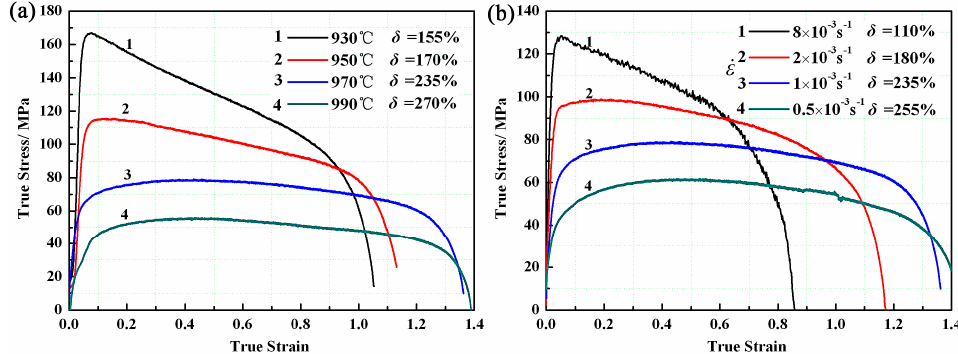
Figure 1. Stress–strain curves for the initial sheet: ( a ) various temperatures and ε − − ×  3 1 =1.0 10 s ; ( b ) various strain rates at 970 °C. ( b ) various strain rates at 970 ◦